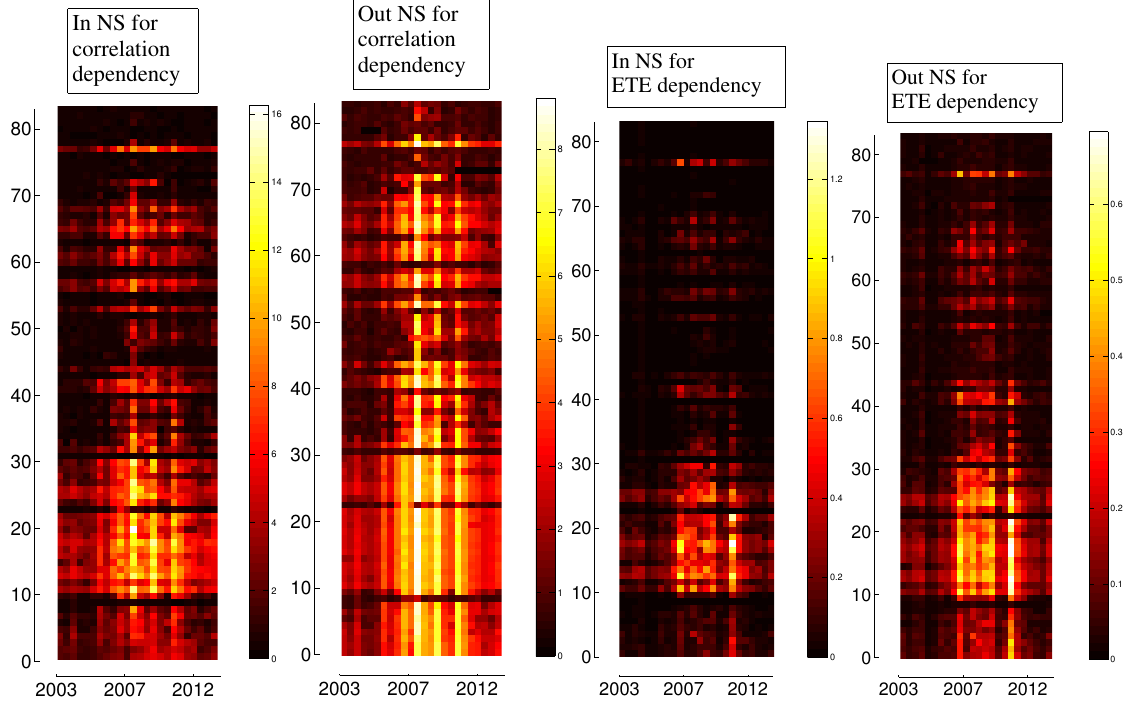
Figure 18. Evolution of in and out node strengths for correlation and ETE